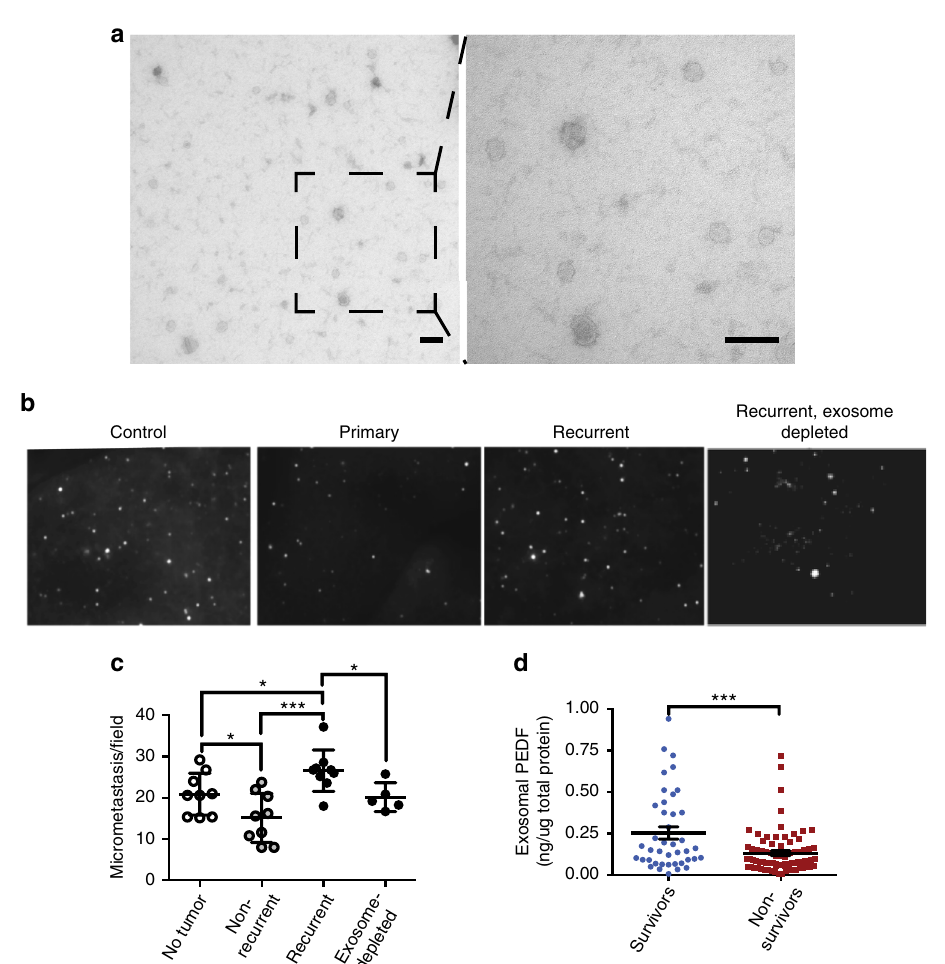
Fig. 6 Exosomes from the sera of patients with non-recurrent melanoma suppress lung metastasis. a Representative TEM of exosomes isolated from the sera of melanoma patients. Scale bar: 100 nm. b Exosomes from the sera of healthy control donors and of patients with primary and recurrent melanoma were injected into athymic nude mice. Exosome-depleted serum from recurrent patients was used as control. Nude mice were injected i.v. three time, with 10 μ g exosomes, 48 h apart followed by injection of CFSE-labeled A375 melanoma cells. The extravasated melanoma cells were counted in the lungs 24 h later. c Analysis of the data presented in b . * P < 0.05, ** P < 0.01, and *** P < 0.001 calculated by Tukey ’ s multiple comparison test with Bonferroni post-test ( n = 9 for tumor-free, non-recurrent and recurrent groups, n = 5 for the group treated with exosome-depleted serum, fi ve random images per animal were analyzed). Mean and s.d. values are shown. d Patients were separated into cohorts according to survival (death from melanoma over > 5-year follow-up). Exosomal PEDF was measured by ELISA and normalized to the total protein content and correlated to survival. Statistical signi fi cance was determined by two-tailed t -test. P < 0.0003. n = 41 (survivors) and n = 79 (non-survivors). Median and s.e.m. values are